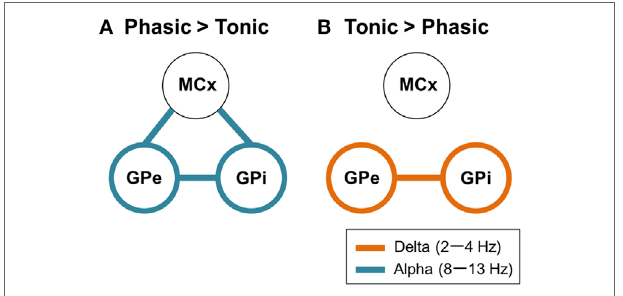
FigUre 5 | Schematic design of frequency-specific characteristic GPi and GPe oscillatory activities and functional couplings segregated by dystonic symptoms. (a) The schematic power and coherence profiles that are more prominent in phasic than in tonic patients. In summary, the alpha GPi power (blue circles) and the alpha GPi coherences with the GPe and MCx (blue lines) are the prominent features in phasic patients. (B) The schematic power and coherence profiles that are more prominent in tonic than in phasic patients. In summary, the delta GPi power (orange circles) and the delta GPi coherences with GPe (orange line) are the prominent features in tonic